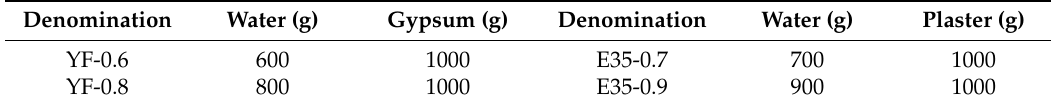
Table 2. Dosages used for mixing the test